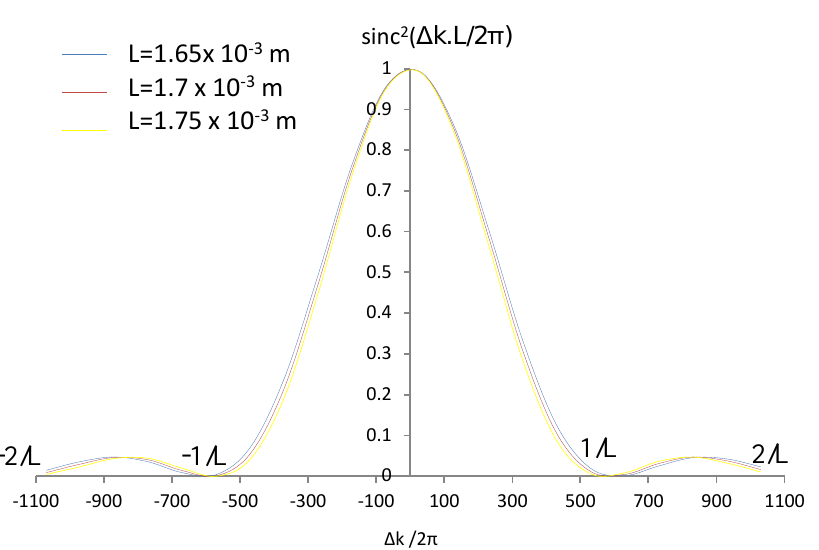
Fig. 6: Factor sinc 2 (Δk.L/2π) Vs. Δk/2π at different length of